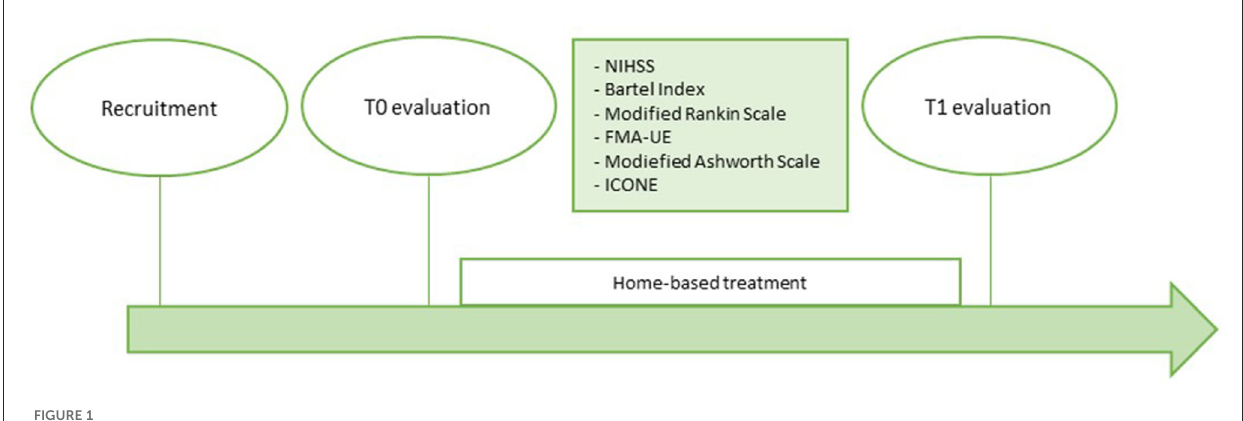
FIGURE1 Timeline.